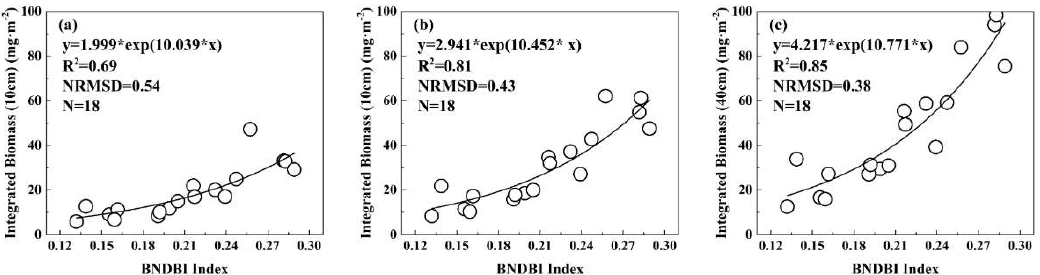
Figure 3. The relationship between BNDBI index and algal biomass integrated from the surface to different water depth. ( a – c ) refers to the depth of 10, 20, 40 cm respectively. (e.g., in ( c ), Y-axis refers to algal biomass integrated from surface to 40 cm).